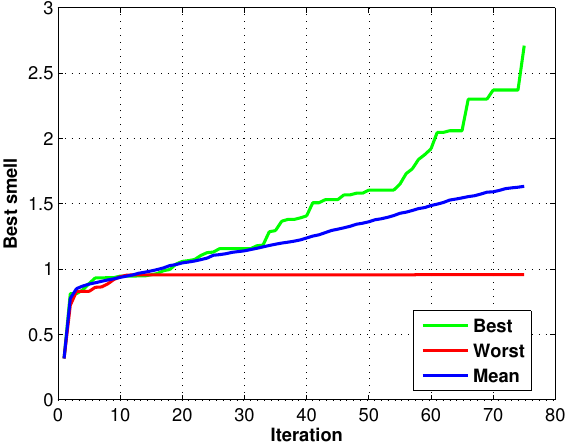
Figure 15. Evolution of the smell function value over the iterations of the statistical study.